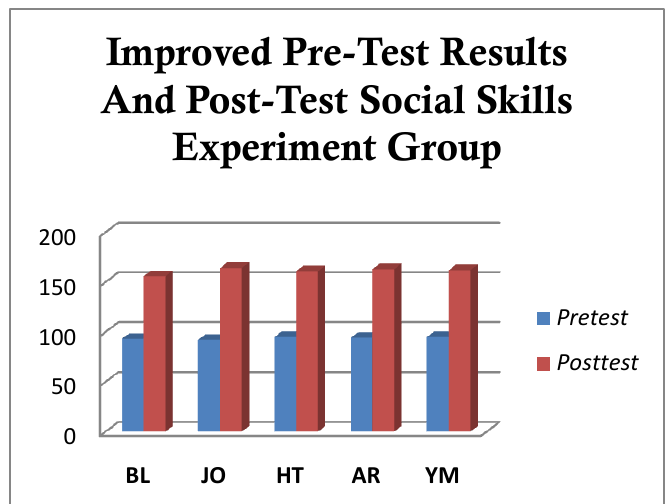
Figure 1. Graph of Pretest Development and Posttest of Social Skill of Experiment Group Based on the results of pre-test and post-test, all learners who become samples experienced an